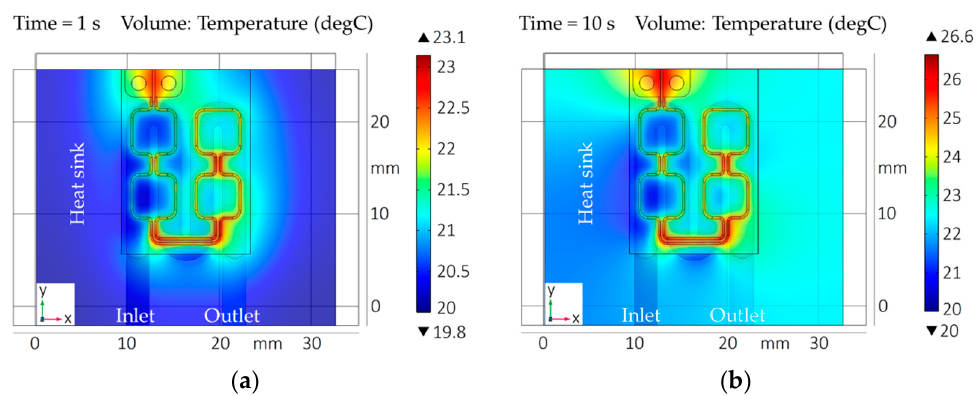
Figure 17. FE simulation of the thermal management based on a passively water-cooled micro coil: ( a ) Coil and heat sink temperature after t h = 1 s; ( b ) Coil and heat sink temperature after t h = 10 s. The resulting inductive heating of the bond frames after t h = 1 s (a) and t h = 10 s (b)